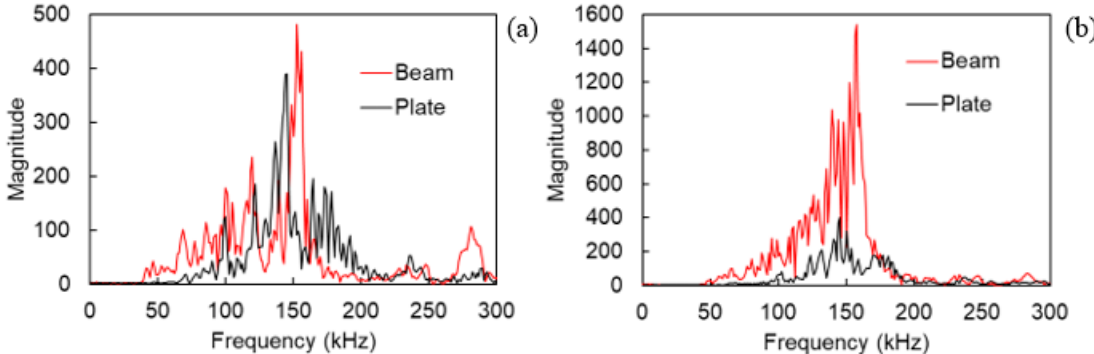
Figure 9. FFT of waveforms received 200 mm away from a pencil lead excitation ( a ) on the surface (out-of-plane), and ( b ) on the side (in-plane), of a beam and a plate geometry.